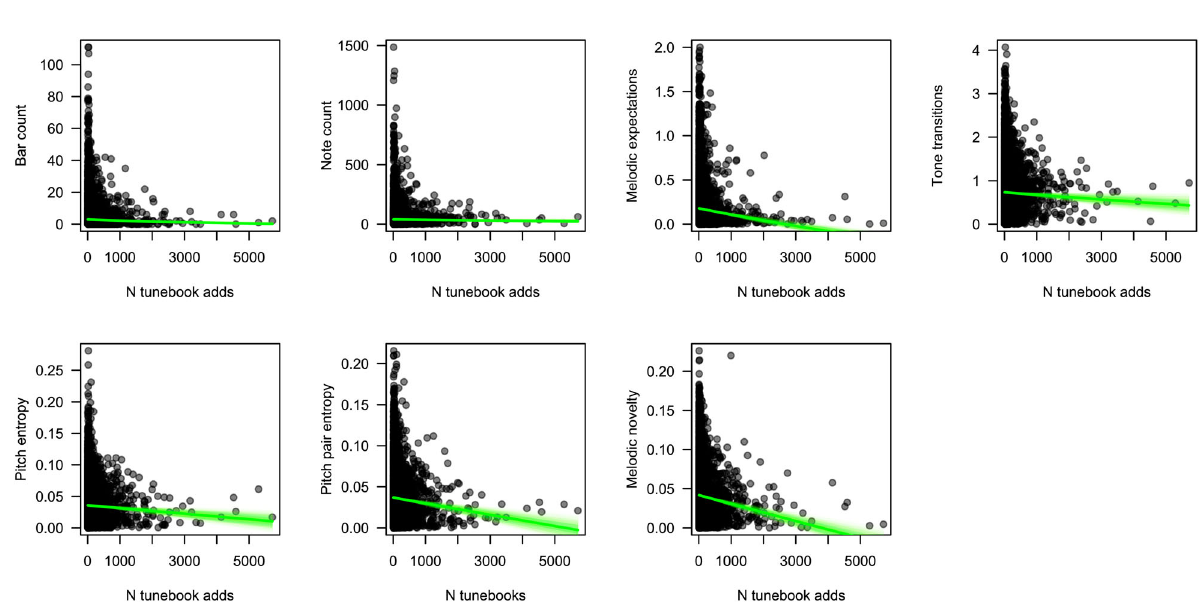
Fig. 2 Scatterplots showing relationships between the seven measures of melodic complexity and popularity at the tune level ( n = 9378). Measures of complexity have been re-scaled so that they represent absolute deviation from the median values, i.e., lower values indicate tunes closer to intermediate complexity while higher values tunes of higher or lower complexity. Shaded areas represent fi t lines from the entire posterior distribution, while thick lines are based on posterior